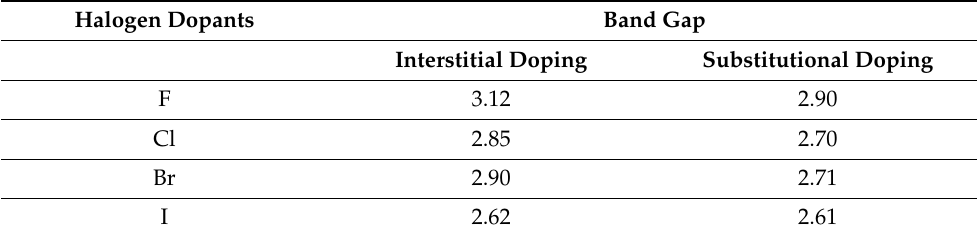
Table 2. Band gap values for every halogen doping